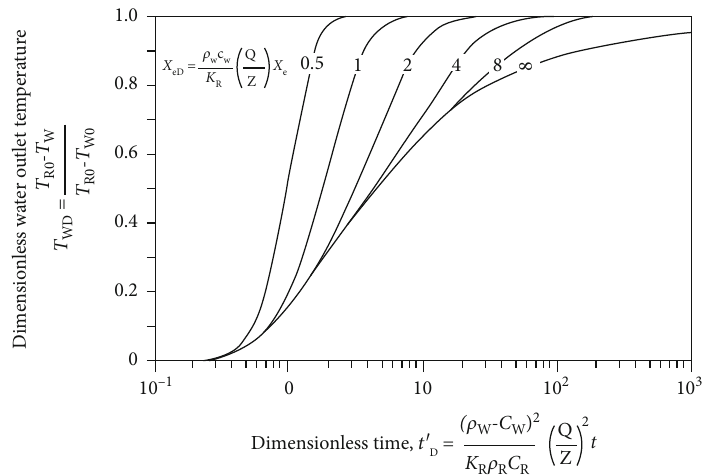
′ (extracted from [4]). WD versus dimensionless time t D